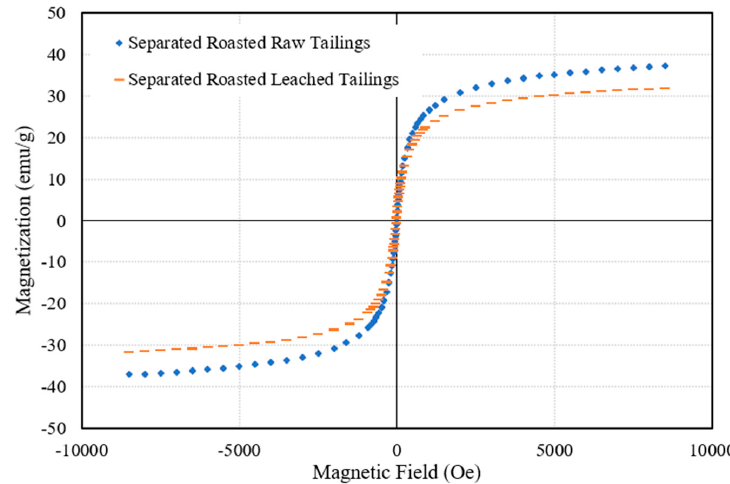
Figure 7. Magnetic hysteresis curves of roasted raw and roasted acid leached tailings.